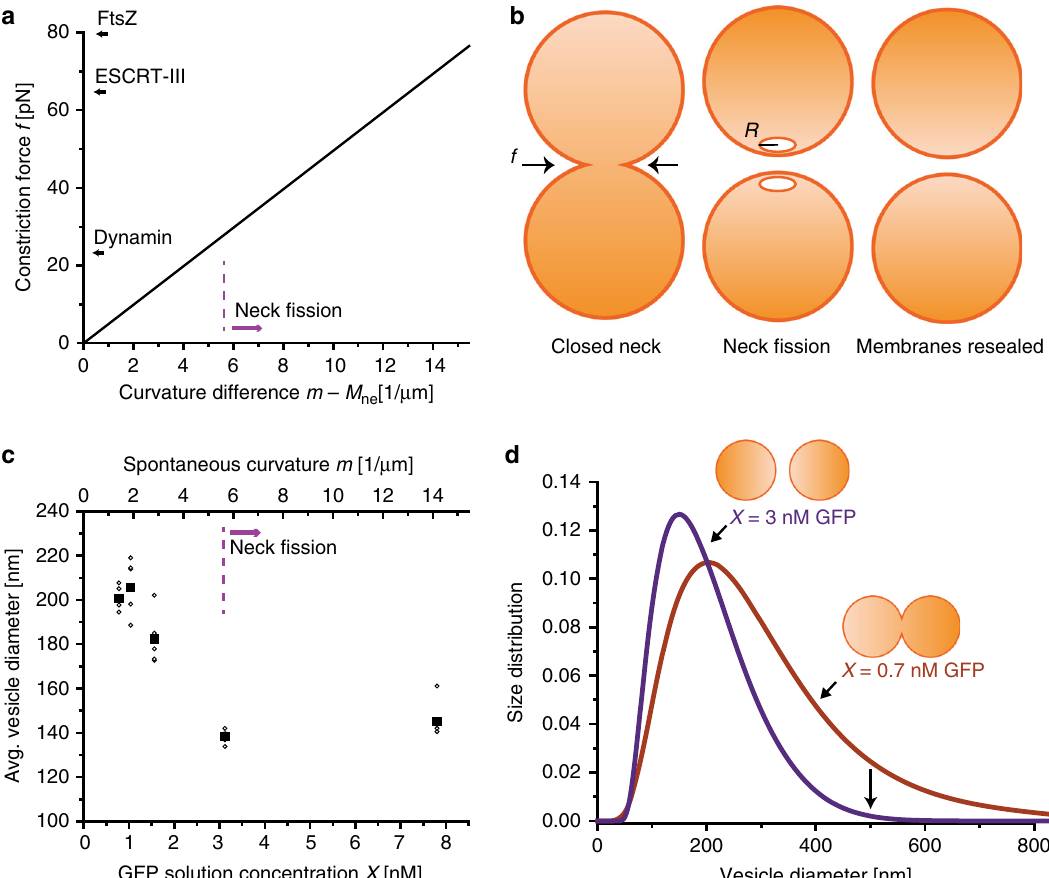
Fig. 4 Vesicle division arising from constriction forces generated by spontaneous curvature. a Constriction force f compressing the closed membrane neck as a function of the curvature difference m − M ne . The straight line corresponds to Eq. (2) with κ = 48 k B T . For comparison, the plot also includes literature values for the constriction forces as generated by the specialized protein complexes of dynamin 4 , ESCRT-III 5 , and FtsZ 6 . b Neck fi ssion and division of a symmetric dumbbell with a closed membrane neck on the left to the two-vesicle state on the right. The free energy barrier between these two states is provided by the intermediate state with two daughter vesicles, each of which has a small membrane pore arising from the broken neck. The radius R of the pores is determined by the neck size before fi ssion. c Average vesicle diameter of LUVs measured by dynamic light scattering as a function of GFP concentration X . Error bars indicate standard deviations from six measurements on the same sample. In total, two independent repeat experiments were performed. The upper x -axis with the spontaneous curvature m is obtained from the calibration curve in Supplementary Fig. 1 and the data in Fig. 2a, as described by Eq. (1). d Size distribution of LUVs obtained for GFP concentration X = 0.7 and 3 nM by dynamic light scattering. These two X -values generate a spontaneous curvature of about 1.5 and 5.5 μ m − 1 . The data in c and d were obtained for 1 mol% anchor-lipids. Source data for panels a , c , and d are provided in the Source Data fi